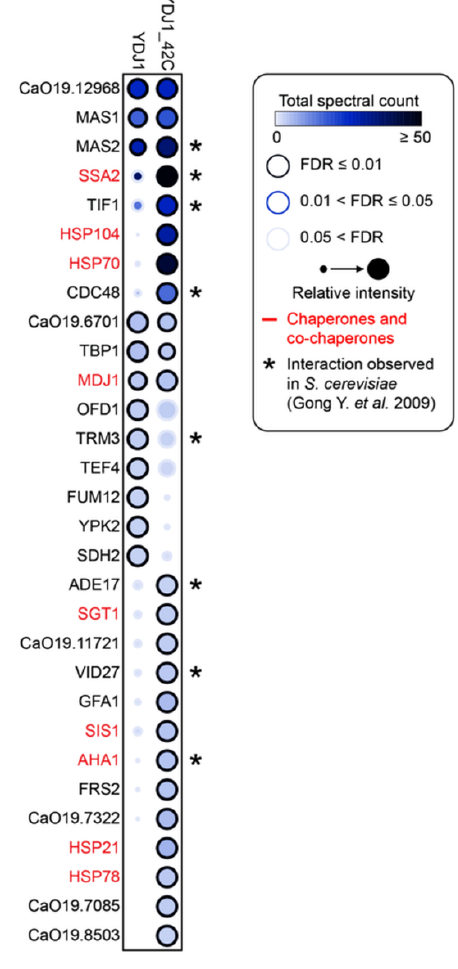
FIGURE 3: The Ydj1 interaction network is modulated by heat shock. AP-MS of 2xFLAG tagged YDJ1 was performed from FLAG- YDJ1/ydj1 Δ cells grown at 30 ° C or subjected to a 15 minute 30°C – 42°C heat shock. Statistically significant Ydj1 interaction partners are shown as a dot plot in which the node color corresponds to the absolute number of spectral count identified for prey pro- teins, the node size corresponds to the relative abundance be- tween the untreated or heat shock sample, and the node edge represents the SAINT FDR rate at which a given prey protein was